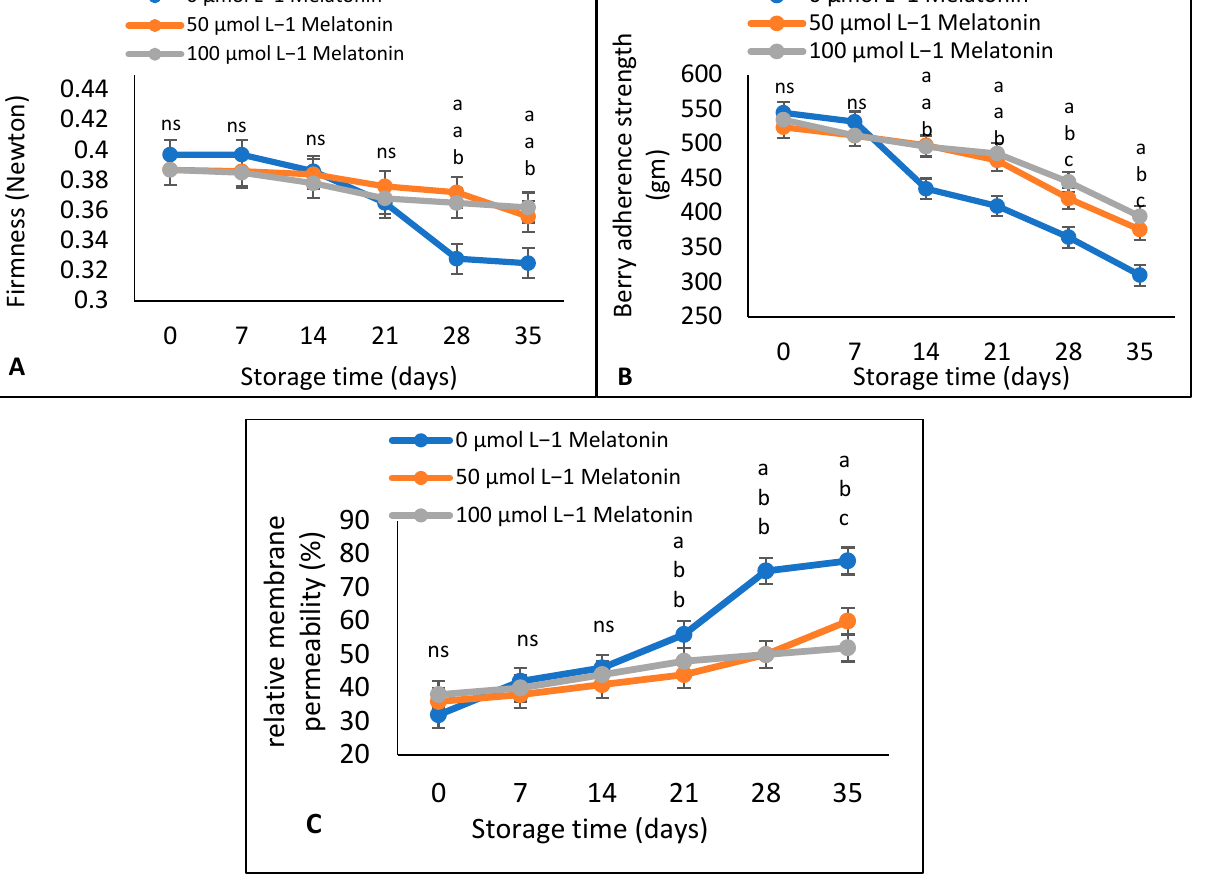
Figure 3. Effect of three concentrations of melatonin on ( A ) firmness, ( B ) berry adherence strength, and ( C ) relative membrane stability of grape berry stored at 0 °C for 35 days. Values are means ± SE from five replicates ( n = 5). Same letter means no significant differences between the values ( p < 0.05) according to the Tukey test.